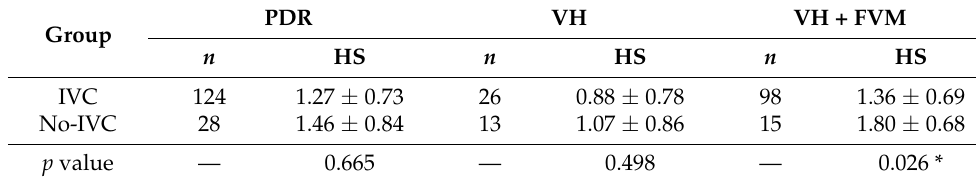
Table 3. Comparison of bleeding scores between the two groups (x ± s).